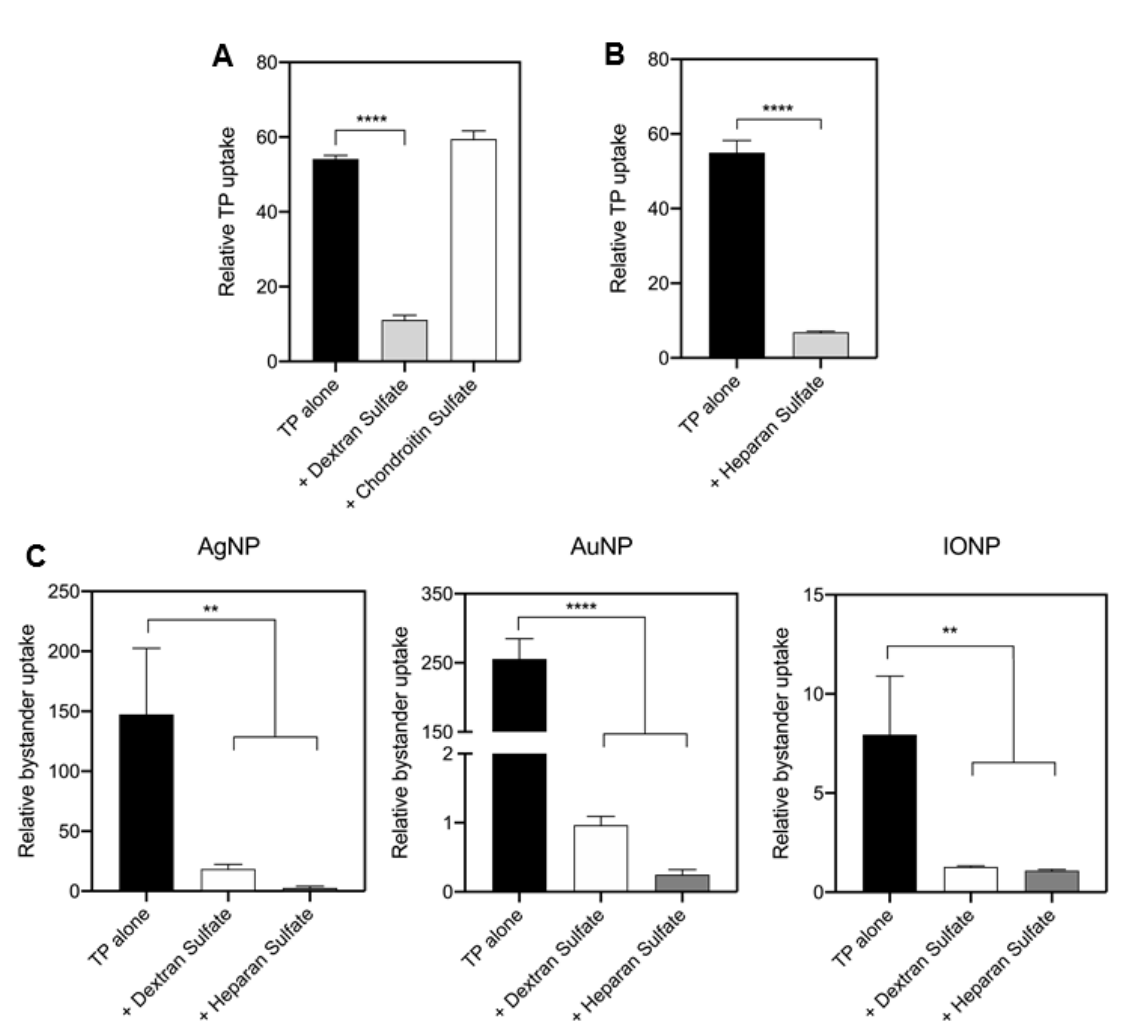
Figure 3. Receptor dependence. ( A ) Blockage of TP uptake by a scavenger receptor inhibitor. CHO cells were incubated with 5 µ g/mL dextran sulfate or chondroitin sulfate together with TP peptide for 1 h, as described in the Methods. Cells were then washed, detached and subjected to flow cytometry. Fluorescence intensity of internalized TP peptide was normalized to that of cells alone ( y -axis). Error bars, mean ± standard deviation (s.d.) ( n = 3). Two tailed Student’s t -test was performed. **** p < 0.0001 in comparison with the TP alone group. ( B ) Blockage of TP uptake by heparan sulfate inhibition. CHO cells were incubated with 1000 µ g/mL soluble heparin together with TP peptide for 1 h, as described in the Methods. Flow cytometry was used to quantify the fluorescence intensity of internalized TP peptide which was further normalized to that of cells alone ( y -axis). Error bars, mean ± standard deviation (s.d.) ( n = 3). Two tailed Student’s t -test was performed. **** p < 0.0001 in comparison with the TP alone group. ( C ) Blockage of NP bystander uptake by heparan sulfate and a scavenger receptor inhibitor. As described in the Methods, CHO cells were incubated with indicated bystander NPs (AgNPs, AuNPs and IONPs) + TP peptide alone, or together with dextran sulfate or heparan sulfate. Fluorescence intensity of bystander NPs per sample was quantified by flow cytometry and normalized to that of cells with bystander NPs alone ( y -axis). Data were presented as mean ± s.d. ( n = 3) and analyzed using one-way ANOVA with Tukey’s multiple comparisons test. ** p < 0.01, **** p < 0.0001 in comparison with the TP alone group.